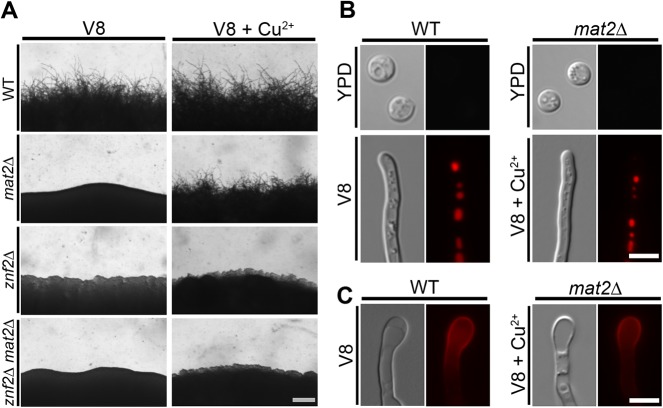
Filamentation shown by the mat2Δ mutant requires the morphogenesis regulator Znf2.(A) Wild type, mat2Δ, znf2Δ, and znf2Δmat2Δ strains were cultured on V8 or V8+copper medium in the dark at 22°C for 7 days before the pictures were taken. Scale bar: 200 μm. (B) Wild type and mat2Δ expressing Cfl1-mCherry under its native promoter were cultured on YPD medium, V8 medium, or V8+Cu2+ medium. (C) Wild type and mat2Δ expressing PGPD1-Dha1-mCherry were cultured on V8 or on V8+Cu2+ medium. Scale bars: 5 μm.